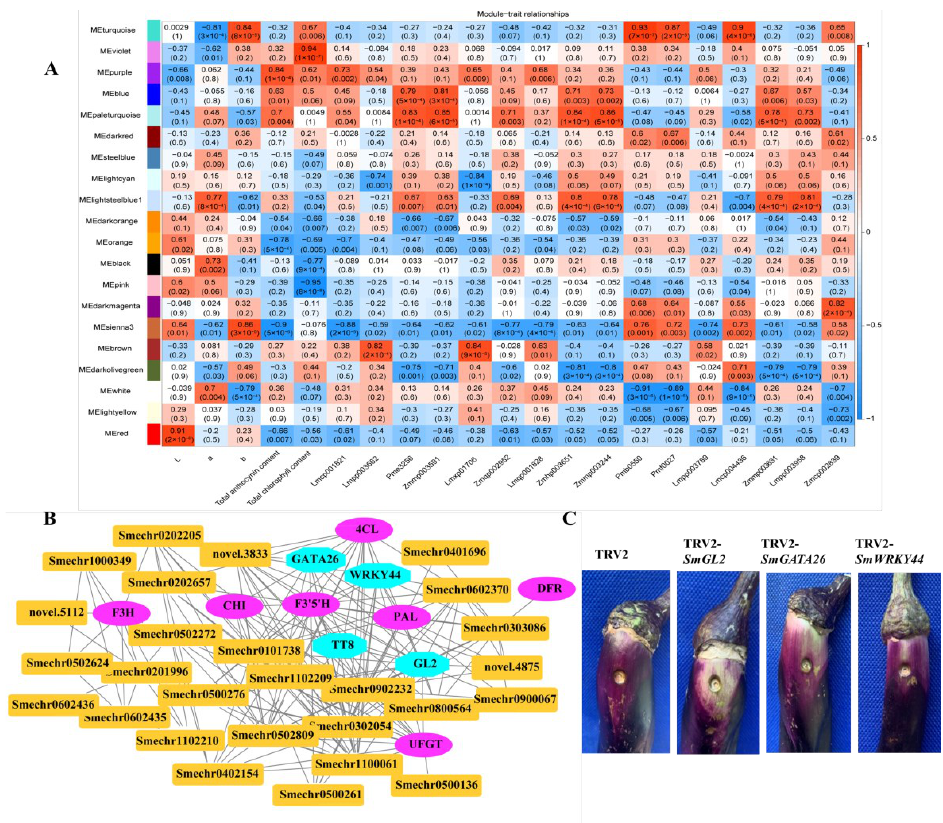
Figure 8. Hierarchical clustering presenting twenty modules with coexpressed genes.